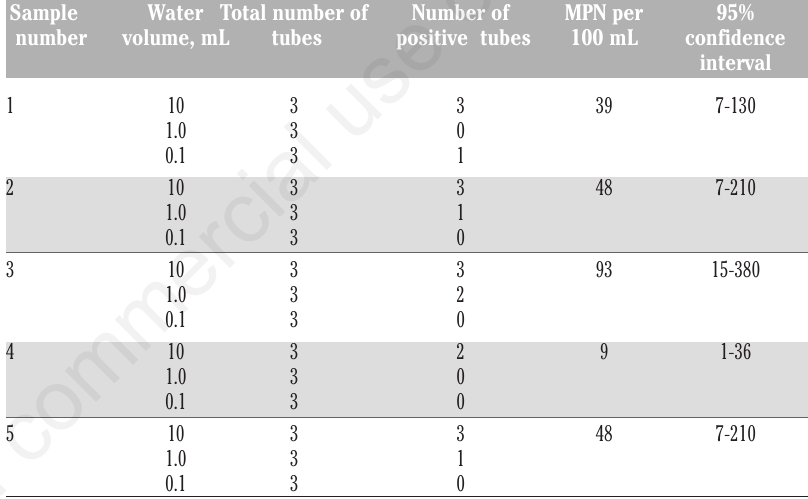
Table 2. The most probable number (MPN) of coliform bacteria in Staff Club swimming pool, OAU, Ile-Ife